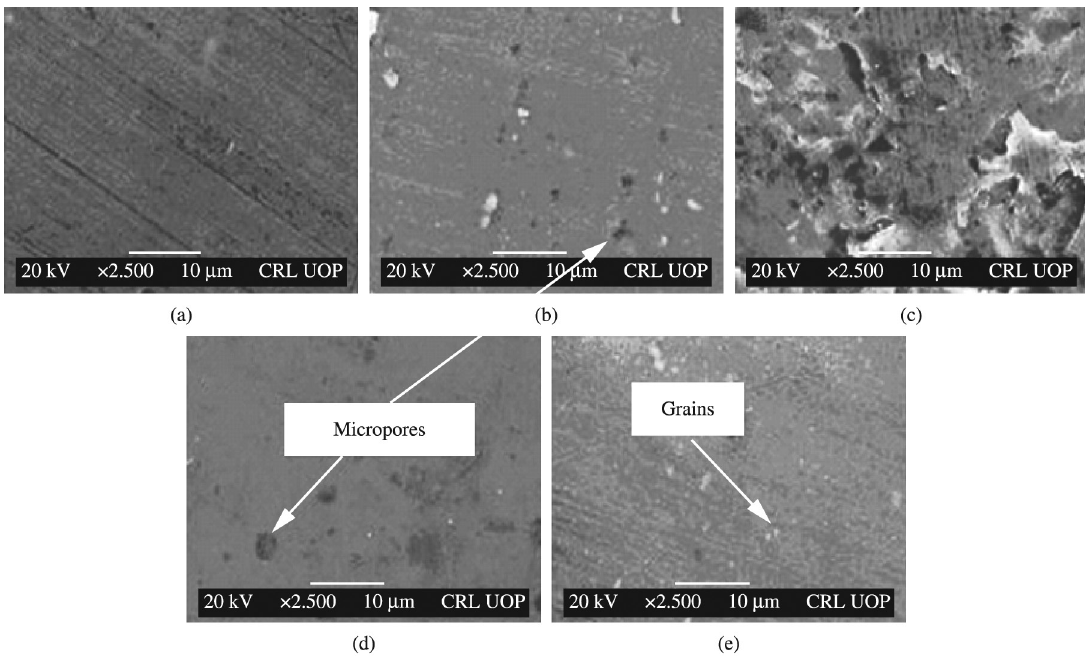
Figure 4. SEM micrographs of Al samples nitrided for different times at fill pressure of 0.5 mbar. (a) Untreated, (b) nitrided for 3 hours, (c) 15 hours, (d) 21 hours and (e) 30